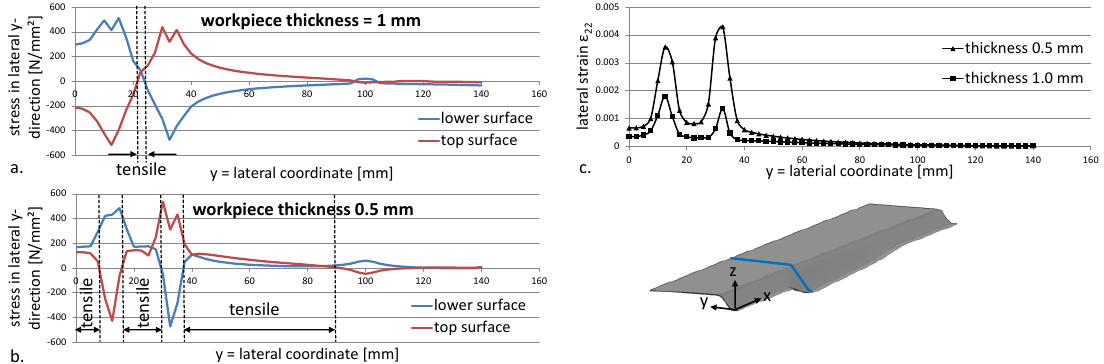
Figure 23. ( a – b ) Lateral stress and ( c ) strain along the cross-section at x = 350 mm (h max,a ) for sheet metal thicknesses 1.0 mm and 0.5 mm.